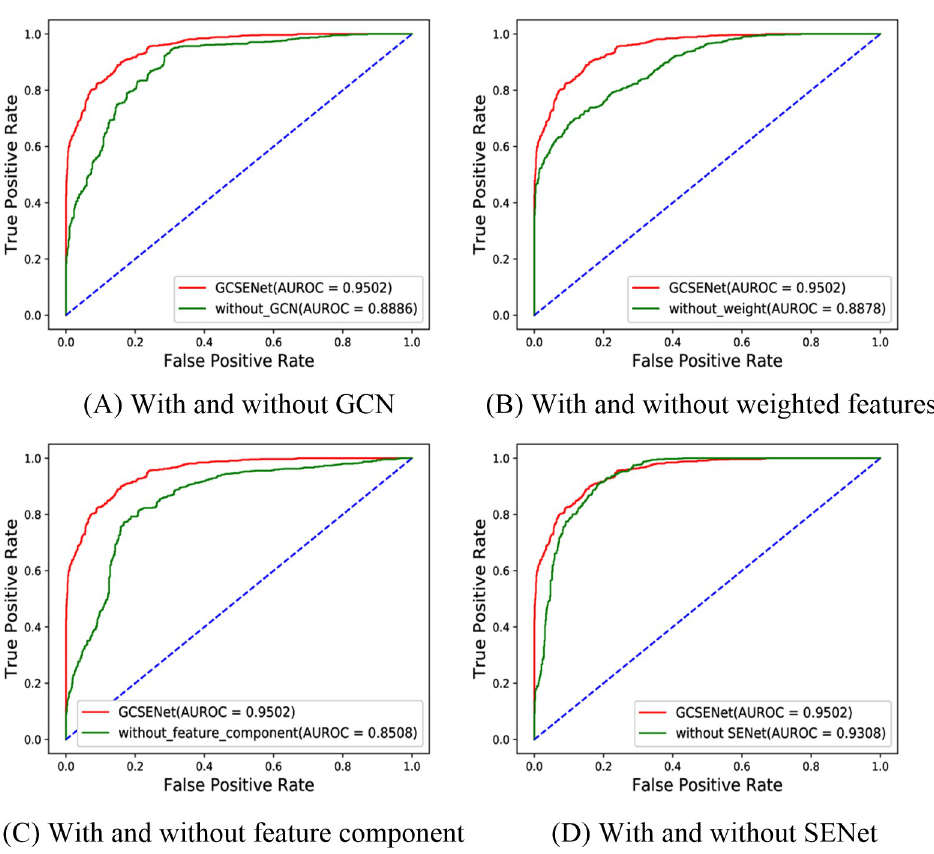
Fig 5. Comparison of ROC curves with different GCSENet components.